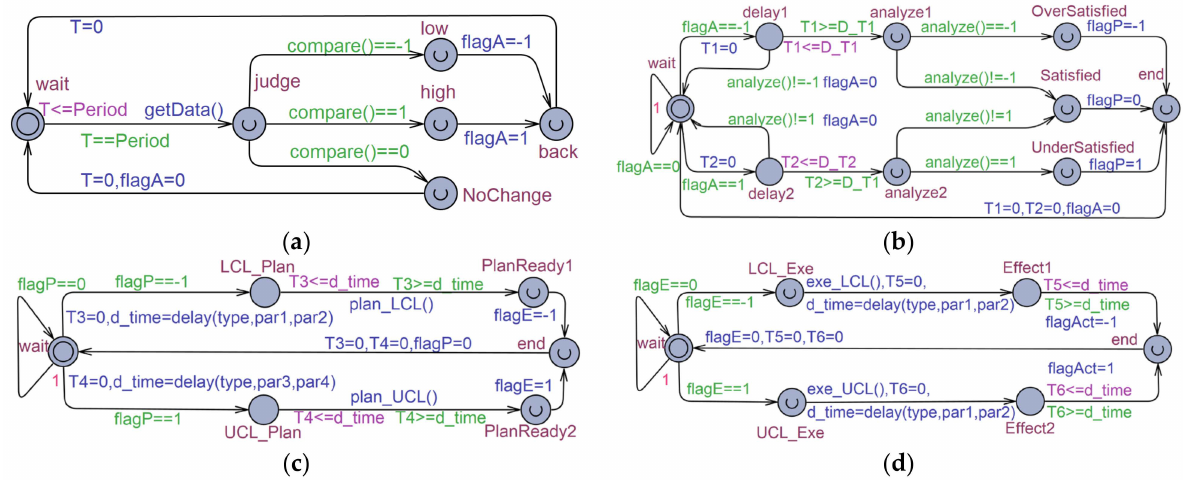
Figure 8. The NPTA based modeling templates for the self-adaptation processes and time behaviors: ( a ) the template for Monitor process and Monitoring Period M Period ; ( b ) The template for Analyze process and Triggering-Delay Time A Delay ; ( c ) the template for Plan process and the uncertainty delay time; and ( d ) the template for Execute process and the uncertainty delay